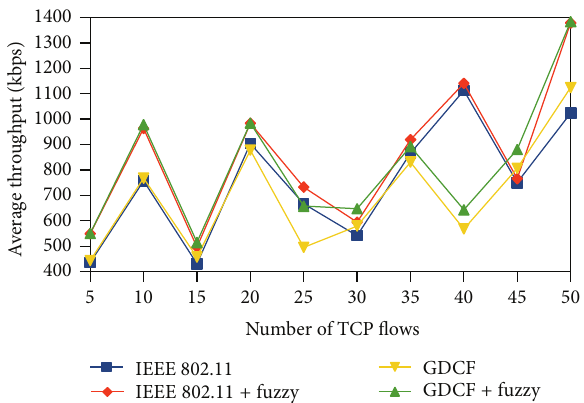
Figure 10: Average throughput for varying nodes.